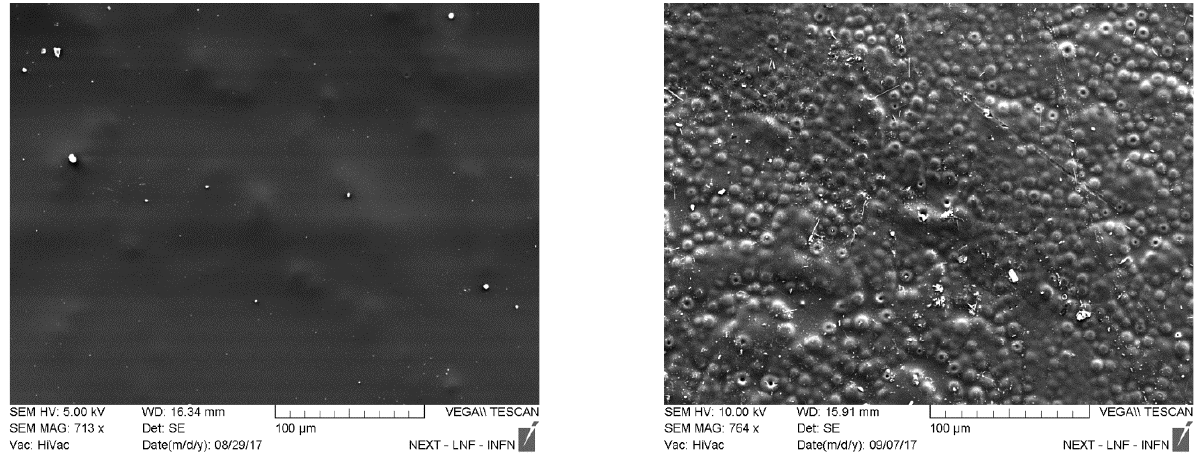
Figure 9. SEM images of the resin surface before and after aging in sulfuric acid.